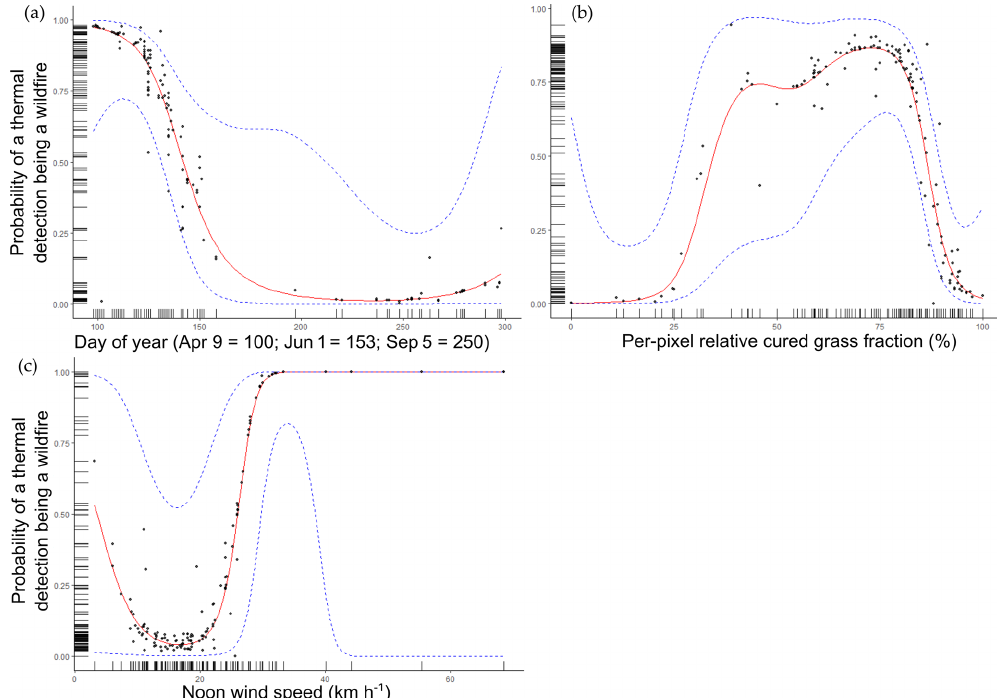
Figure 5. Generalized additive model outputs for a binomial model of agricultural fire vs. wildfire. The ticks along each plot axis show the marginal distribution of the data.